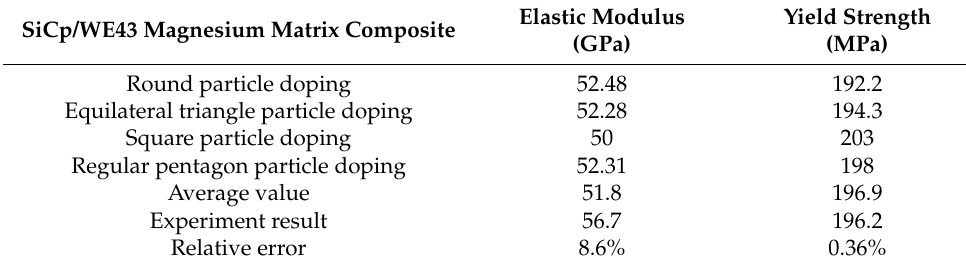
Table 2. Comparison of simulation results with experimental